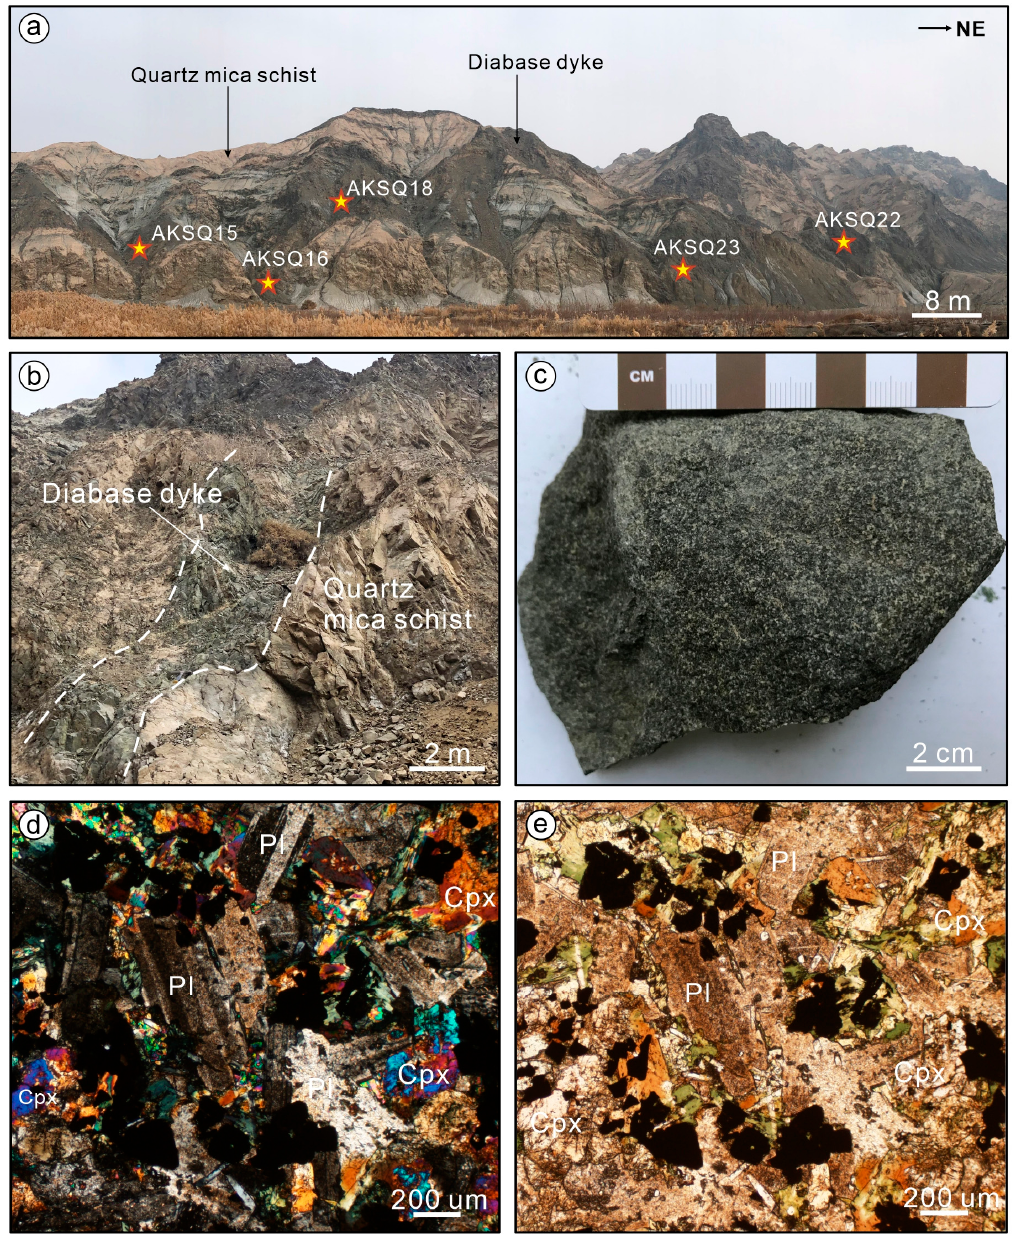
Figure 3. Photographs and photomicrographs showing the occurrence and mineralogy of the diabase dykes in the Aksu area. ( a , b ) Neoproterozoic diabase dykes intruding the deformed Neoproterozoic Aksu Group; ( c ) hand specimen of the Aksu Neoproterozoic diabase; ( d , e ) photomicrograph of diabase showing the mineral assemblage of the diabase under cross-polarized light. Abbreviations: Pl = plagioclase, Cpx =